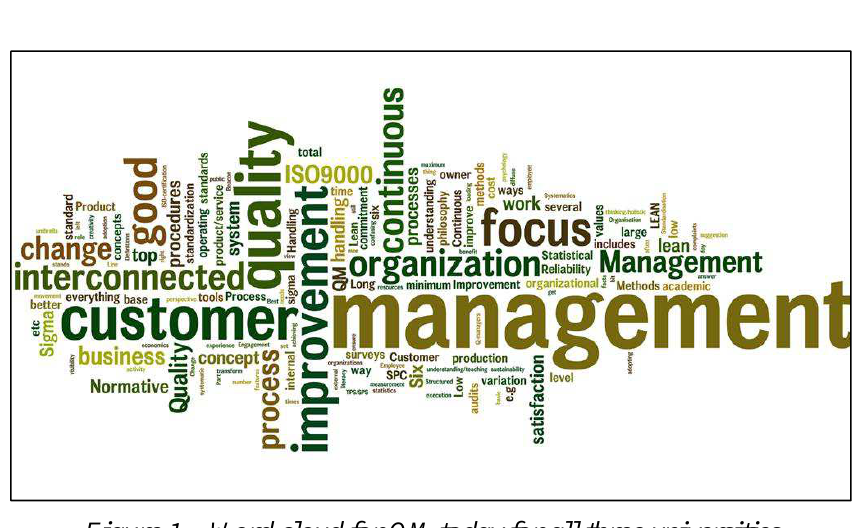
Figure 1 – Word cloud for QM today for all three universities